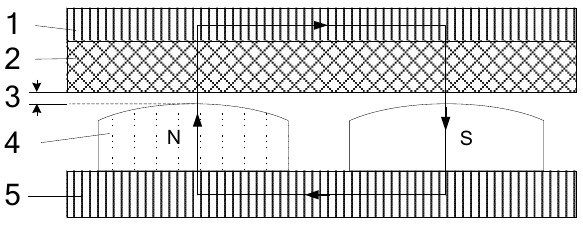
Figure 2. Main magnetic circuit (1—stator; 2—windings; 3—air gap; 4—permanent magnet; 5—rotor back iron).